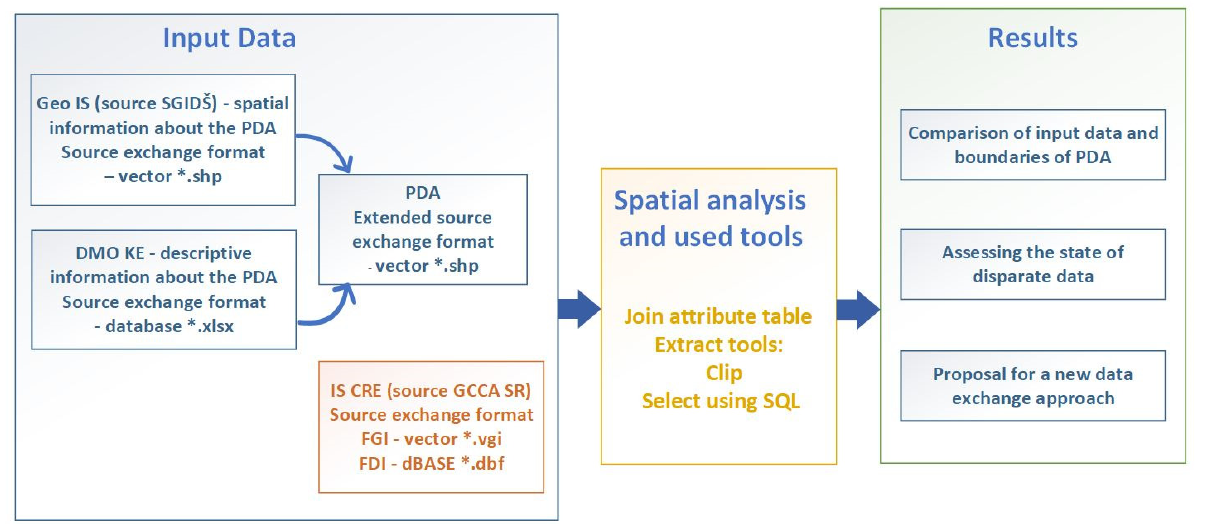
Figure 2. Processing data within the PDA data registration.